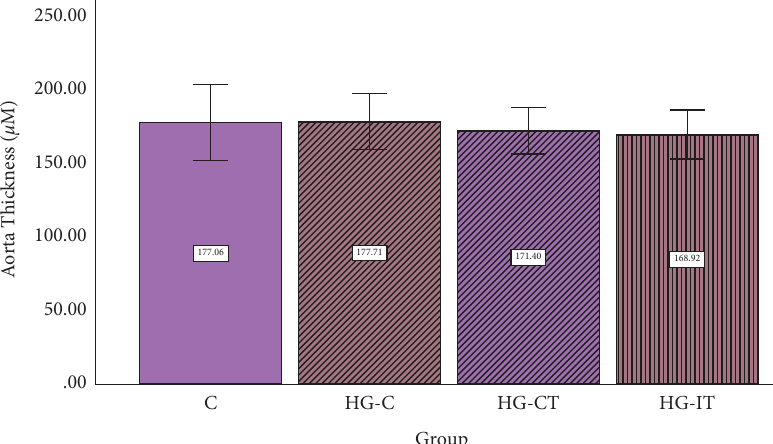
Figure 10: Aortic wall thickness within each group. c: control group; HG-C: hyperglycemic control group; HG-CT: hyperglycemic rats that performed moderate-intensity continuous training (MICT); HG-IT: hyperglycemic rats that performed high-intensity interval training (HIIT). Te error bars represent the standard deviation of measurements.